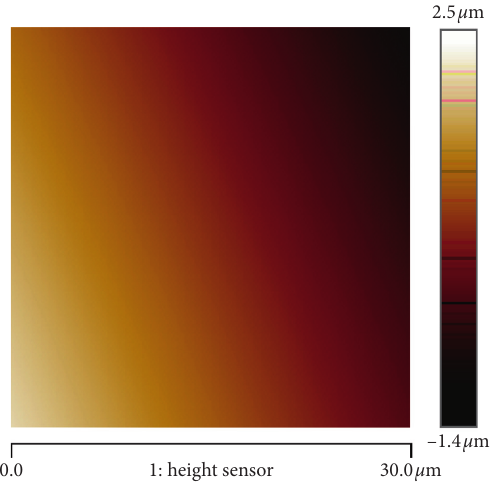
Figure 6: Nanomorphology diagram of #70 matrix asphalt.